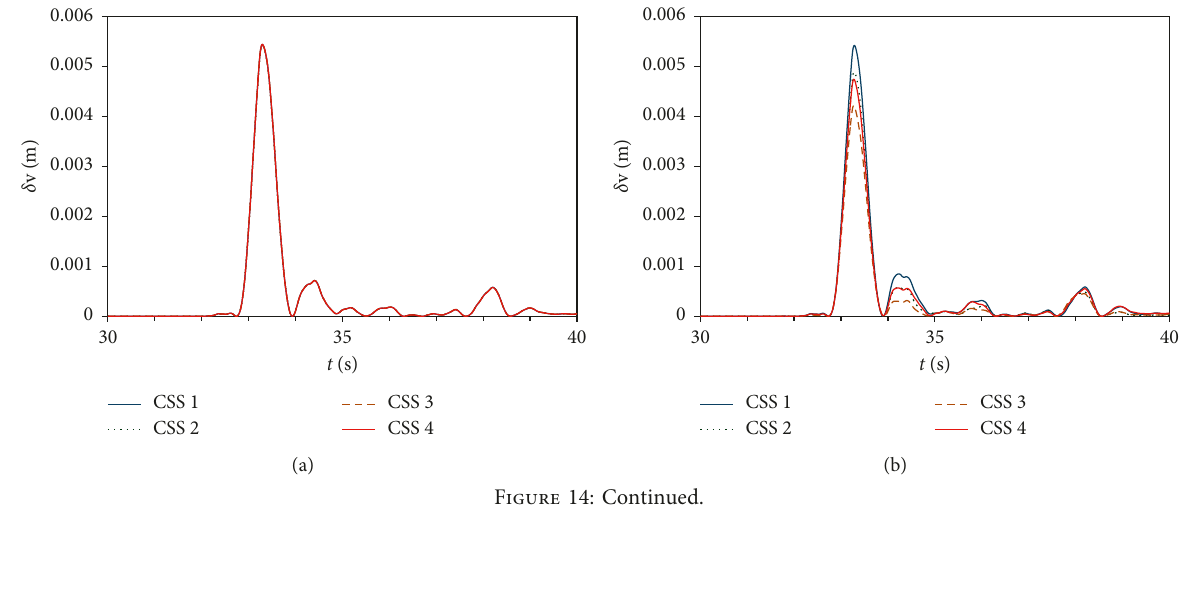
Figure 13: Four-column frame: displacements in the plane xy due to an acceleration input along x for (a) C0, (b) C3 with μ with μ b